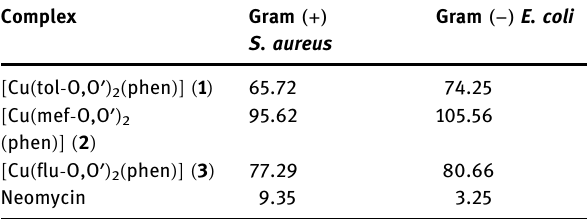
Table 2: Minimum inhibitory concentrations ( µg mL − 1 ) of Cu ( II ) complexes against S. aureus and E. coli